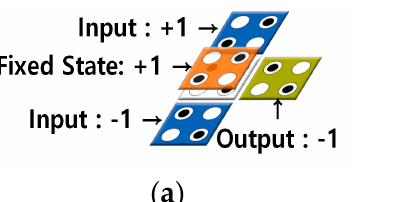
expression of diagonal transmission.